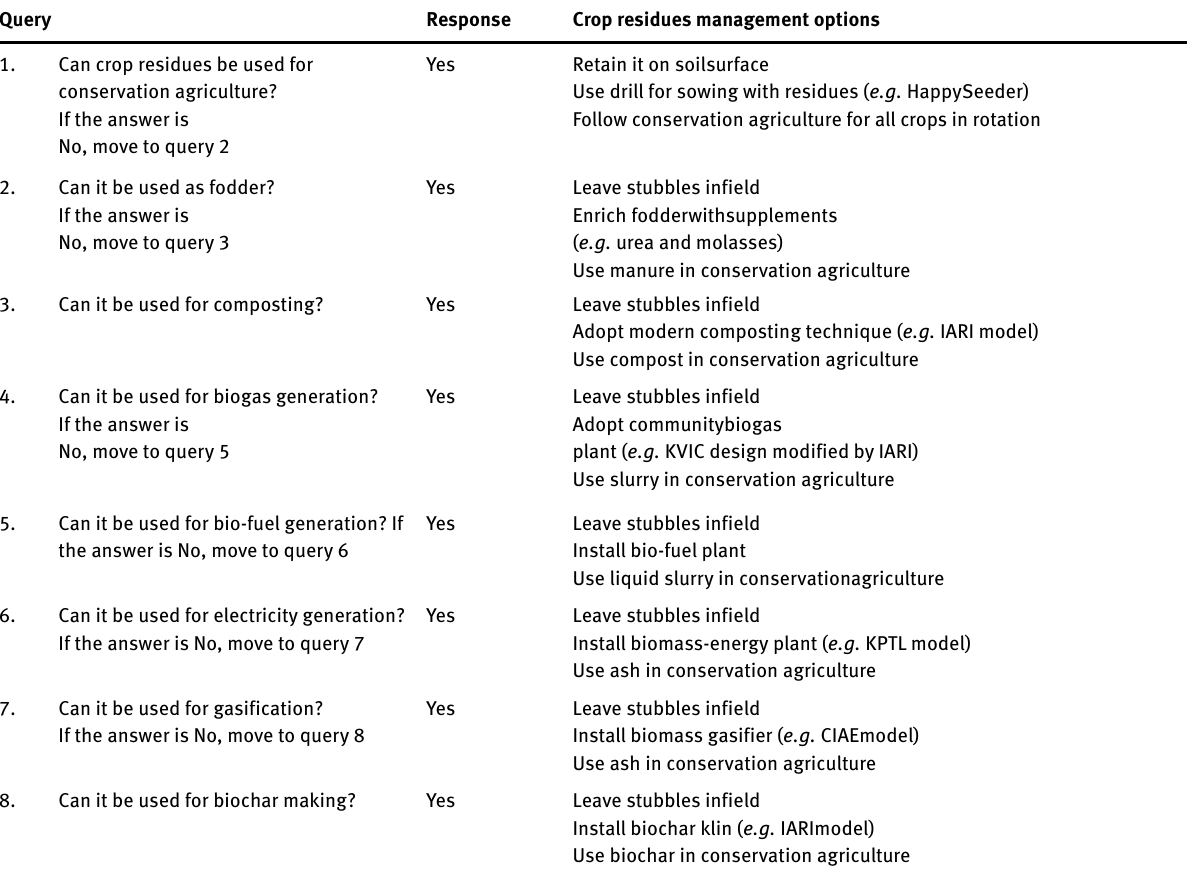
Table 8: Model plan for managing crop residues at local and regional scales Query